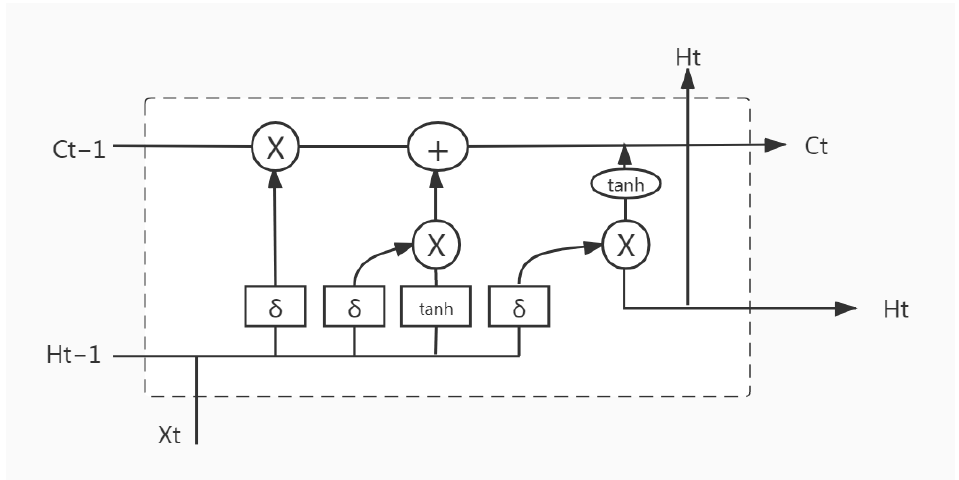
Figure 1. Network structure diagram of the LSTM model.